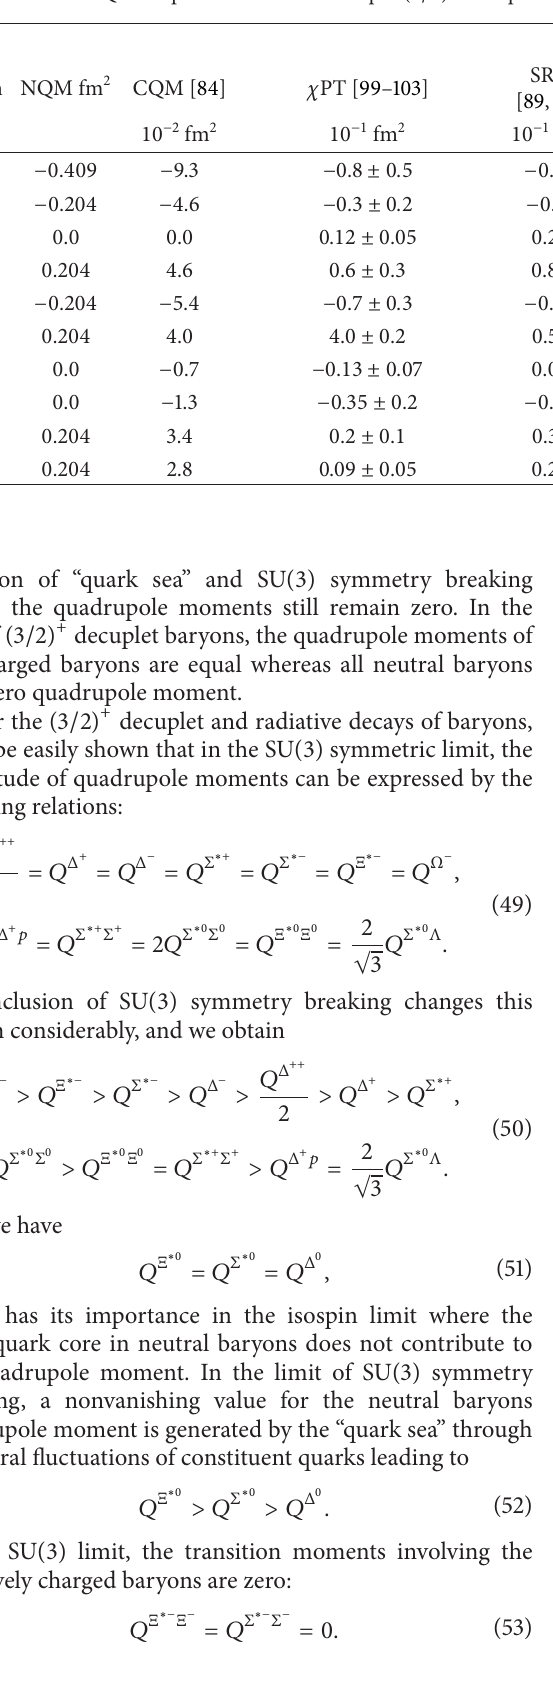
Table 10: Quadrupole moments of the spin (3/2) + decuplet baryons in 𝜒 CQM using GPM and SU (3) symmetry breaking. Baryon NQM fm 2 CQM [84] 𝜒 PT